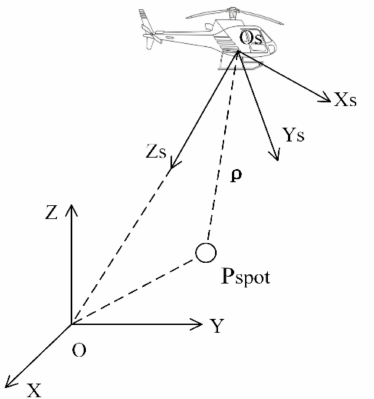
Figure 5. Schematic diagram of the laser-tight geometric positioning